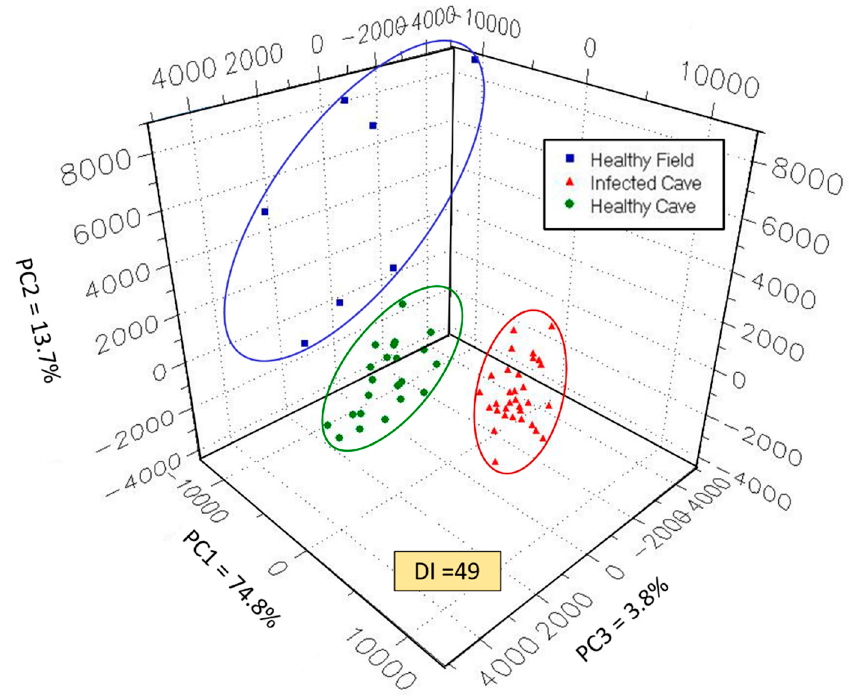
Figure 3. Principal component analysis e-nose aroma-plot of P. subflavus bat whole-body air VOC